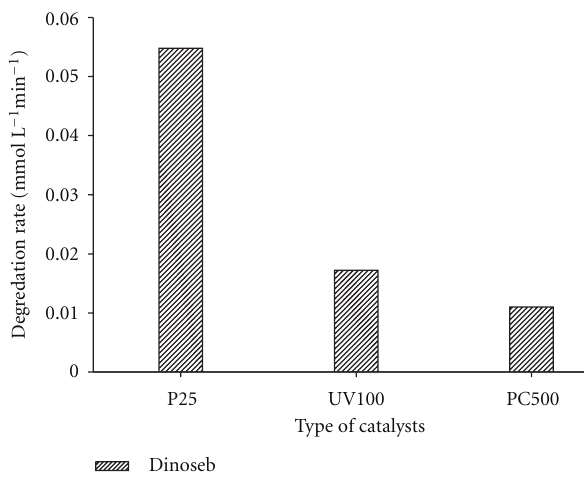
Figure 1: HPLC analysis of Dinoseb in an aqueous suspension of TiO 2 . Column C-18, eluent 70:30 (acetonitrile: water). Exper- imental conditions: 0.22mM Dinoseb, V = 125mL, photocatalyst TiO 2 (Degussa P25, 1 gL − 1 ), immersion well photo reactor, 125 W